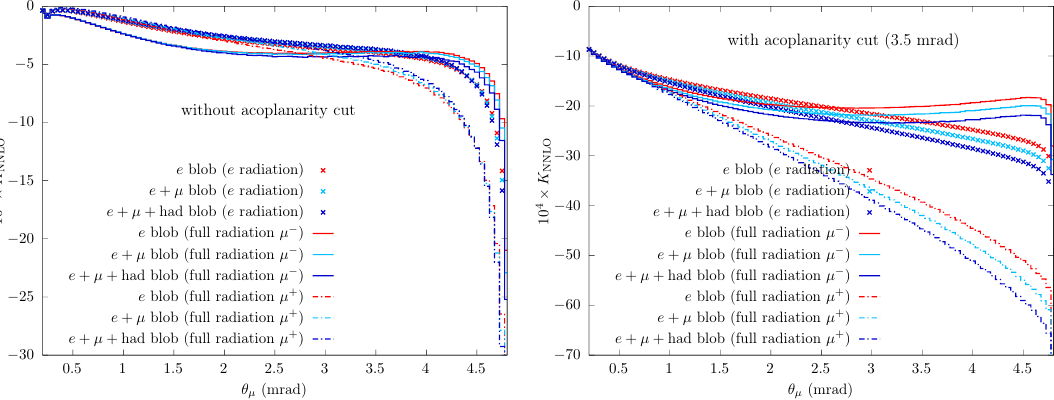
Figure 14. Left: differential K NNLO factor on θ µ distribution, including the complete set of NNLO virtual leptonic pair corrections. Right: the same observable including the acoplanarity